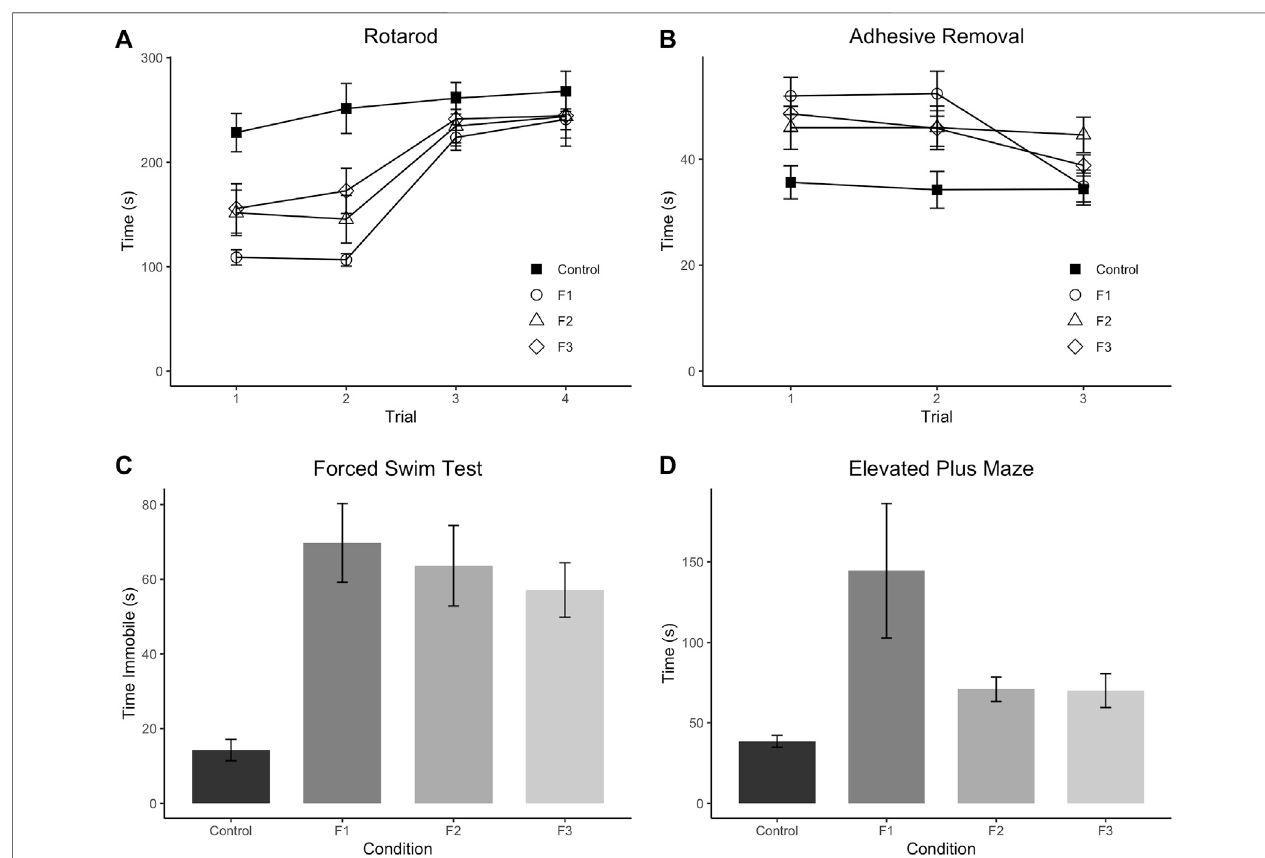
FIGURE 2 | Multi-modality behavioral analysis. Results from behavioral testing in P20 control, F1, F2, and F3 mice in Accelerated Rotarod (A) , Adhesive Removal test (B) ,ElevatedPlusMaze (C) ,andForcedSwimTest (D) .F1micedisplaysigni fi cantlydecreasedscoresontrials1and2oftheRotarodcomparedtocontrols,andF2 mice only show signi fi cantly decreased scores on Trial 2 compared to controls. All three experimental generations display signi fi cantly increased scores on average acrossthethree trials oftheAdhesive Removaltest compared tocontrols.F1 mice display signi fi cantly increased time spent ontheopen arms oftheElevated Plus Maze compared to controls, and all 3 PrEE generations display signi fi cantly increased time spent immobile compared to controls in the Forced Swim Test.